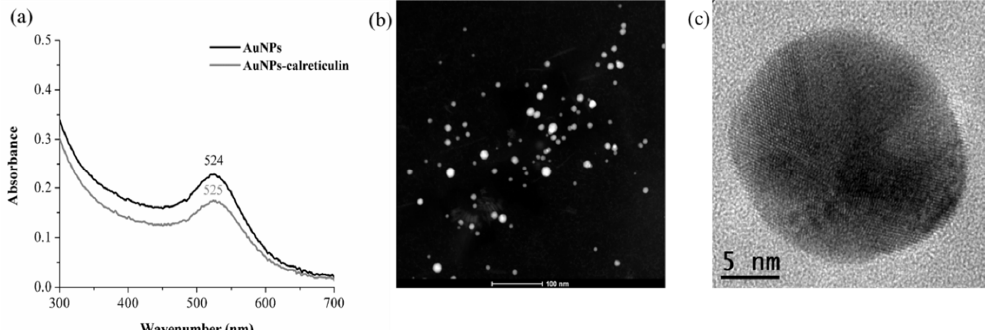
Figure 1. UV-VIS spectra and transmission electron microscope (TEM) images. ( a ) Plasmon resonance (SPR) for gold nanoparticles (AuNPs) and AuNPs–calreticulin obtained using chitosan as a reducing agent; the maximun of absorbance observed was 524 nm, corresponding to the formation SPR of gold